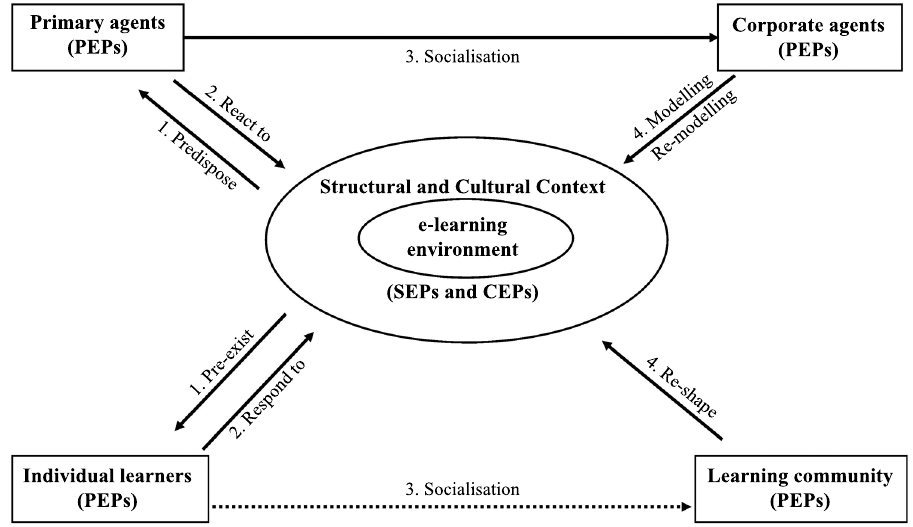
Figure 2. The emergence of the (e-)learning community. Note: CEP, Cultural Emergent Power; PEP, Personal Emergent Power; SEP, Structural Emergent Power. In an e-learning environment, learners come to study on an online course as individuals. The pre-existence of course content, structure, pedagogy, teaching